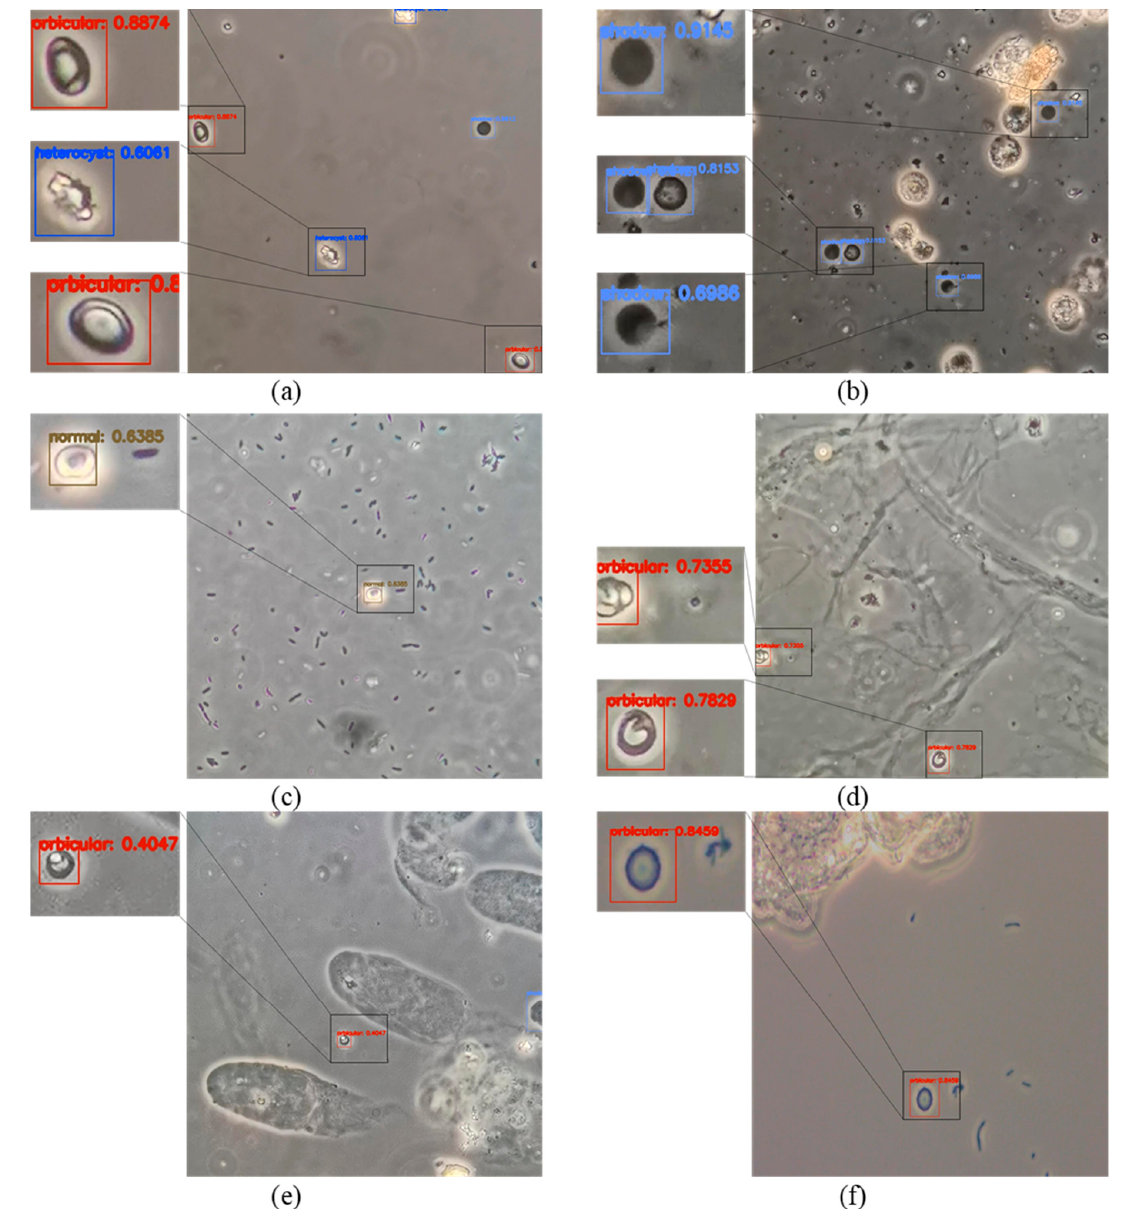
Figure 7. The YOLOv4 detection results of U-RBC fusion images: ( a ) without interference, ( b ) interfered with the leukocytes, ( c ) interfered with the bacteria, ( d ) interfered with the mucus, ( e ) interfered with the casts, and ( f ) interfered with the epithelial cells.